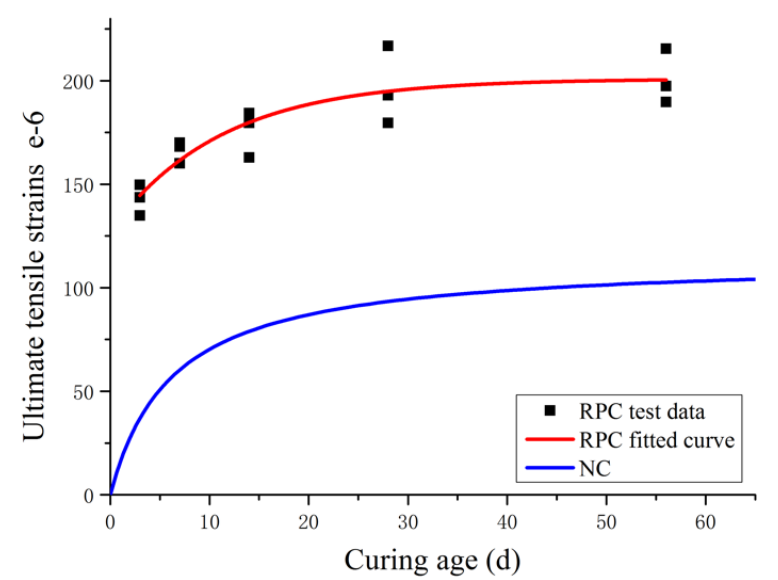
Figure 9. Relationship between ultimate tensile strain and curing age.